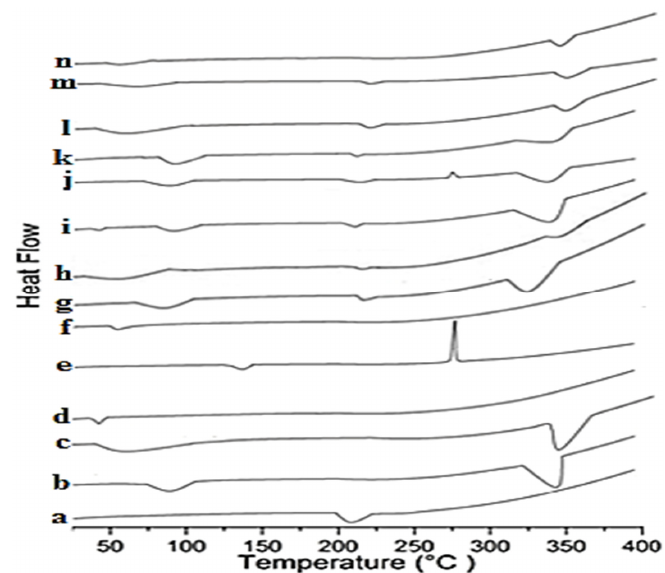
Figure 5. DSC thermograms of ( a ) DIF; ( b ) βCD; ( c ) HPβCD; ( d ) PVA; ( e ) CMC-Na; ( f ) PXM-188; ( g ) DIF/βCD (1:2); ( h ) DIF/HPβCD (1:2); ( i ) DIF/βCD (1:2) PVA 10%; ( j ) DIF/βCD (1:2) CMC-Na 10%; ( k ) DIF/βCD (1:2) PXM-188 10%; ( l ) DIF/HPβCD (1:2) PVA 10%; ( m ) DIF/HPβCD (1:2) CMC-Na 10%; ( n ) DIF/HPβCD (1:2) PXM-188 10%.